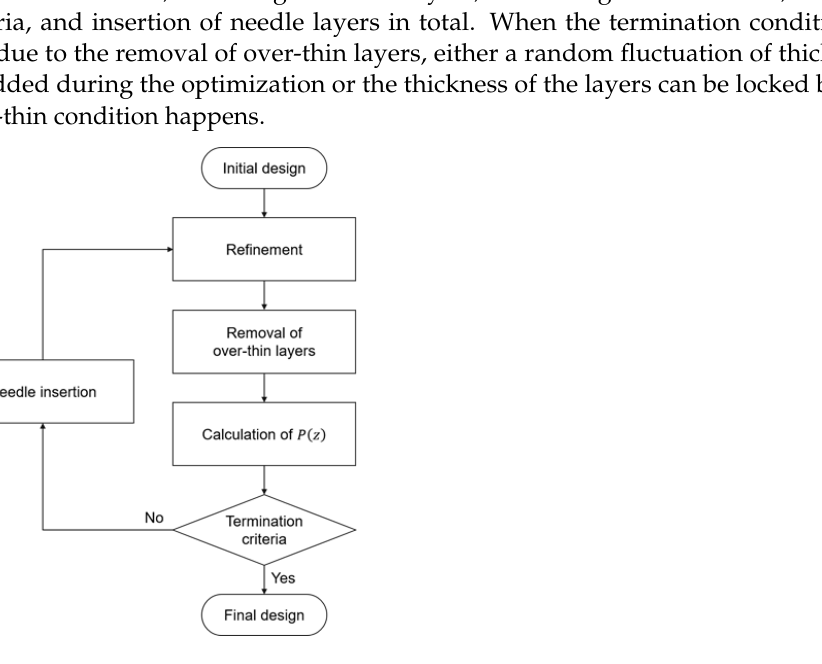
Figure 5. The flowchart of the needle optimization algorithm by Tikhonravov et al. [11].